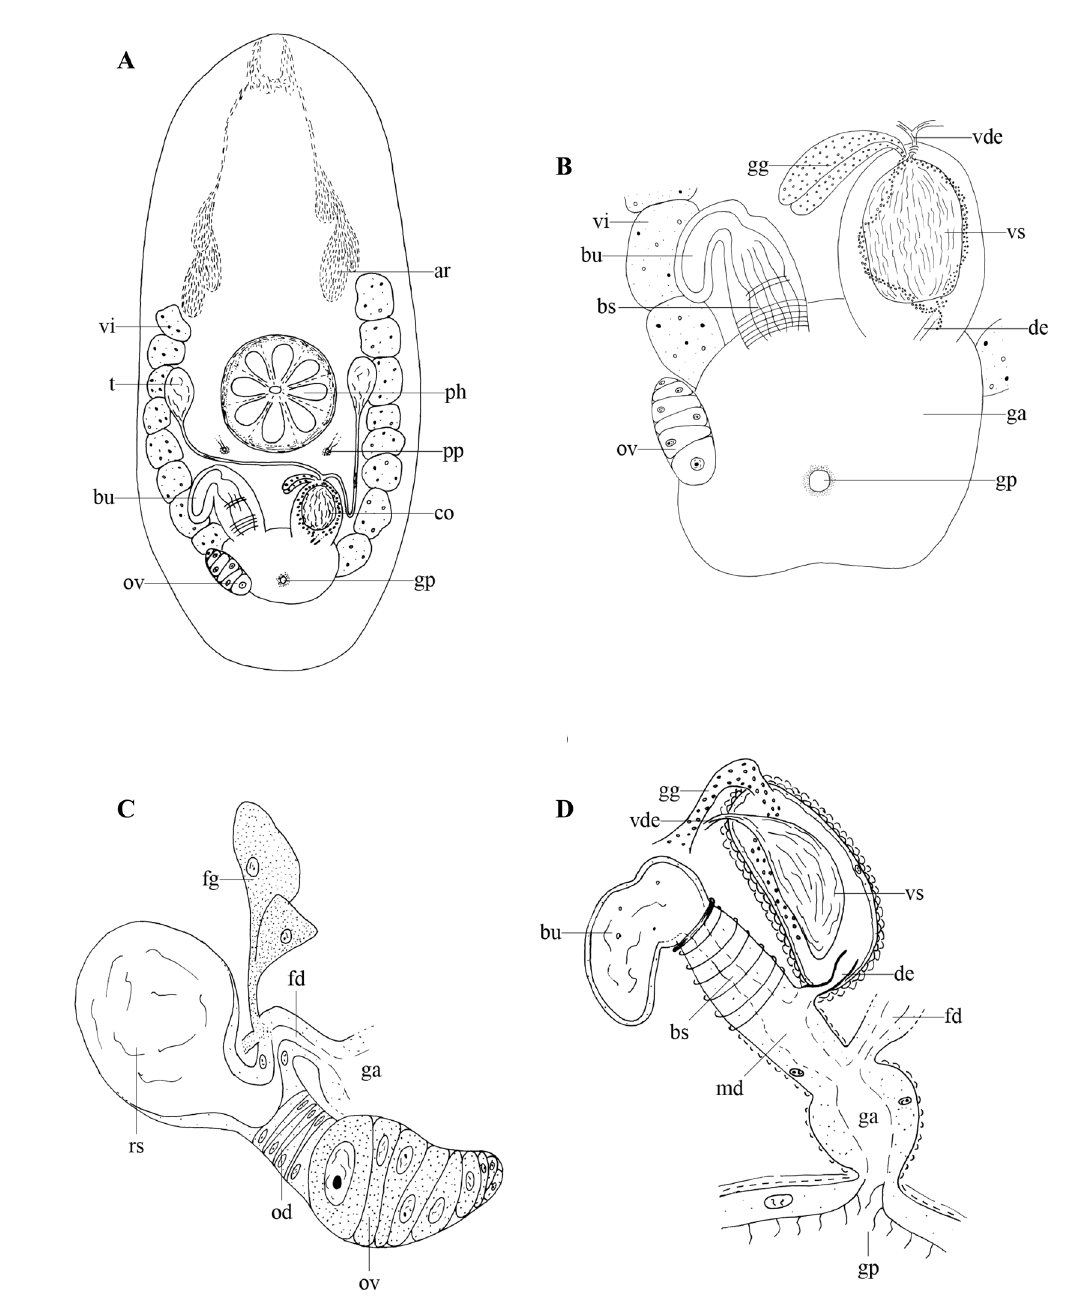
Fig. 9. Olisthanellinella rotundula Reisinger, 1924. A . Internal organisation of a live specimen. B . Organisation of the genital system of a live specimen. C . Reconstruction of female reproductive organs based on horizontal sections. D . Reconstruction of male reproductive organs based on sagittal